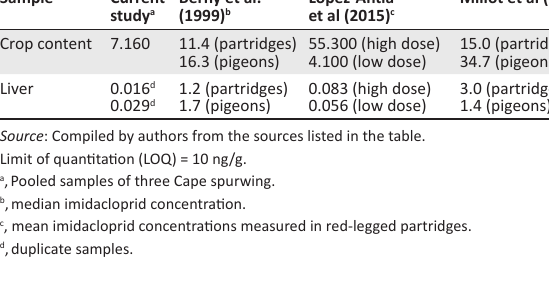
TABLE 1: Imidacloprid concentrations ( μ g/g wet weight) in crop contents and liver samples collected from poisoned birds.